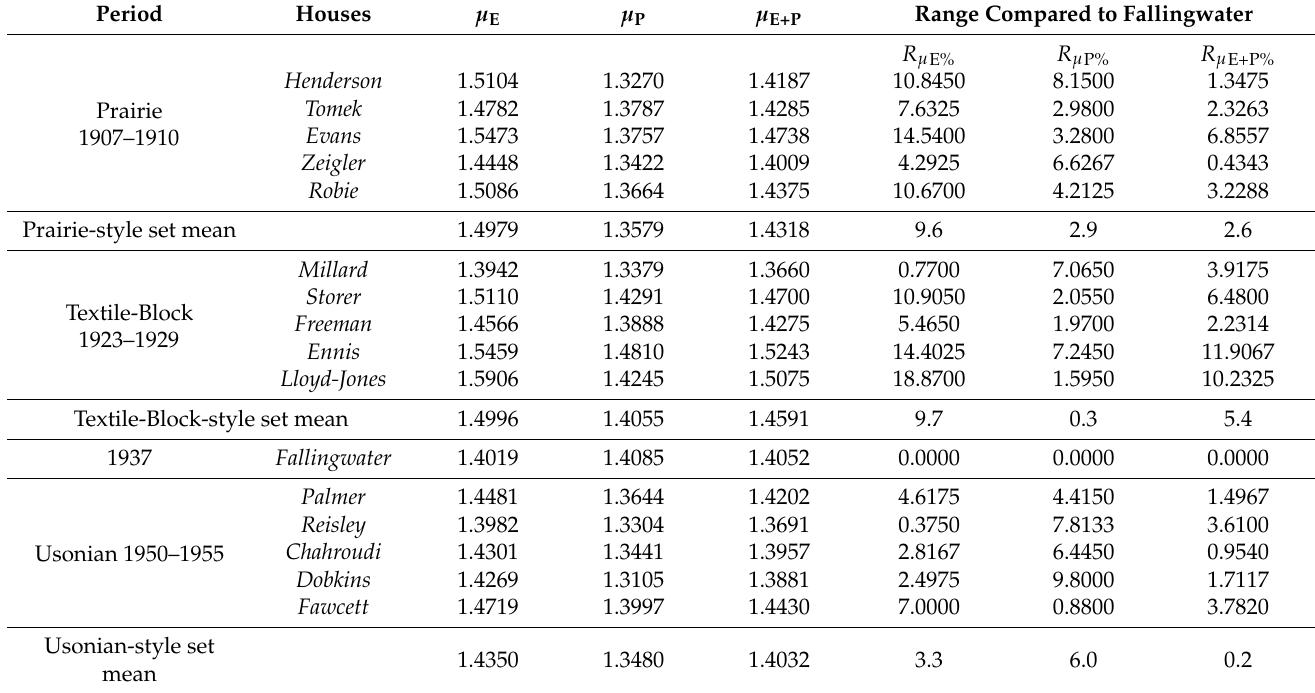
Table 7. Comparison of mean results for all